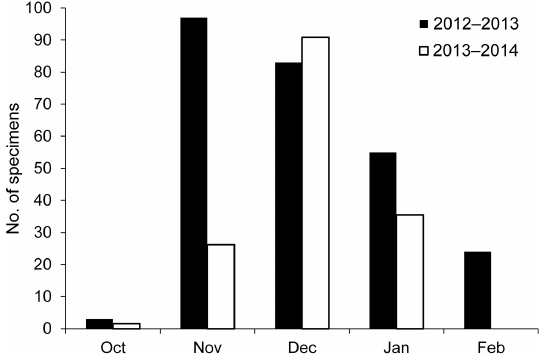
Figure 5. Sardine hatch date distribution back-calculated from date of catch and estimated age. Different colors represent the two sam- pling periods in the Gulf of